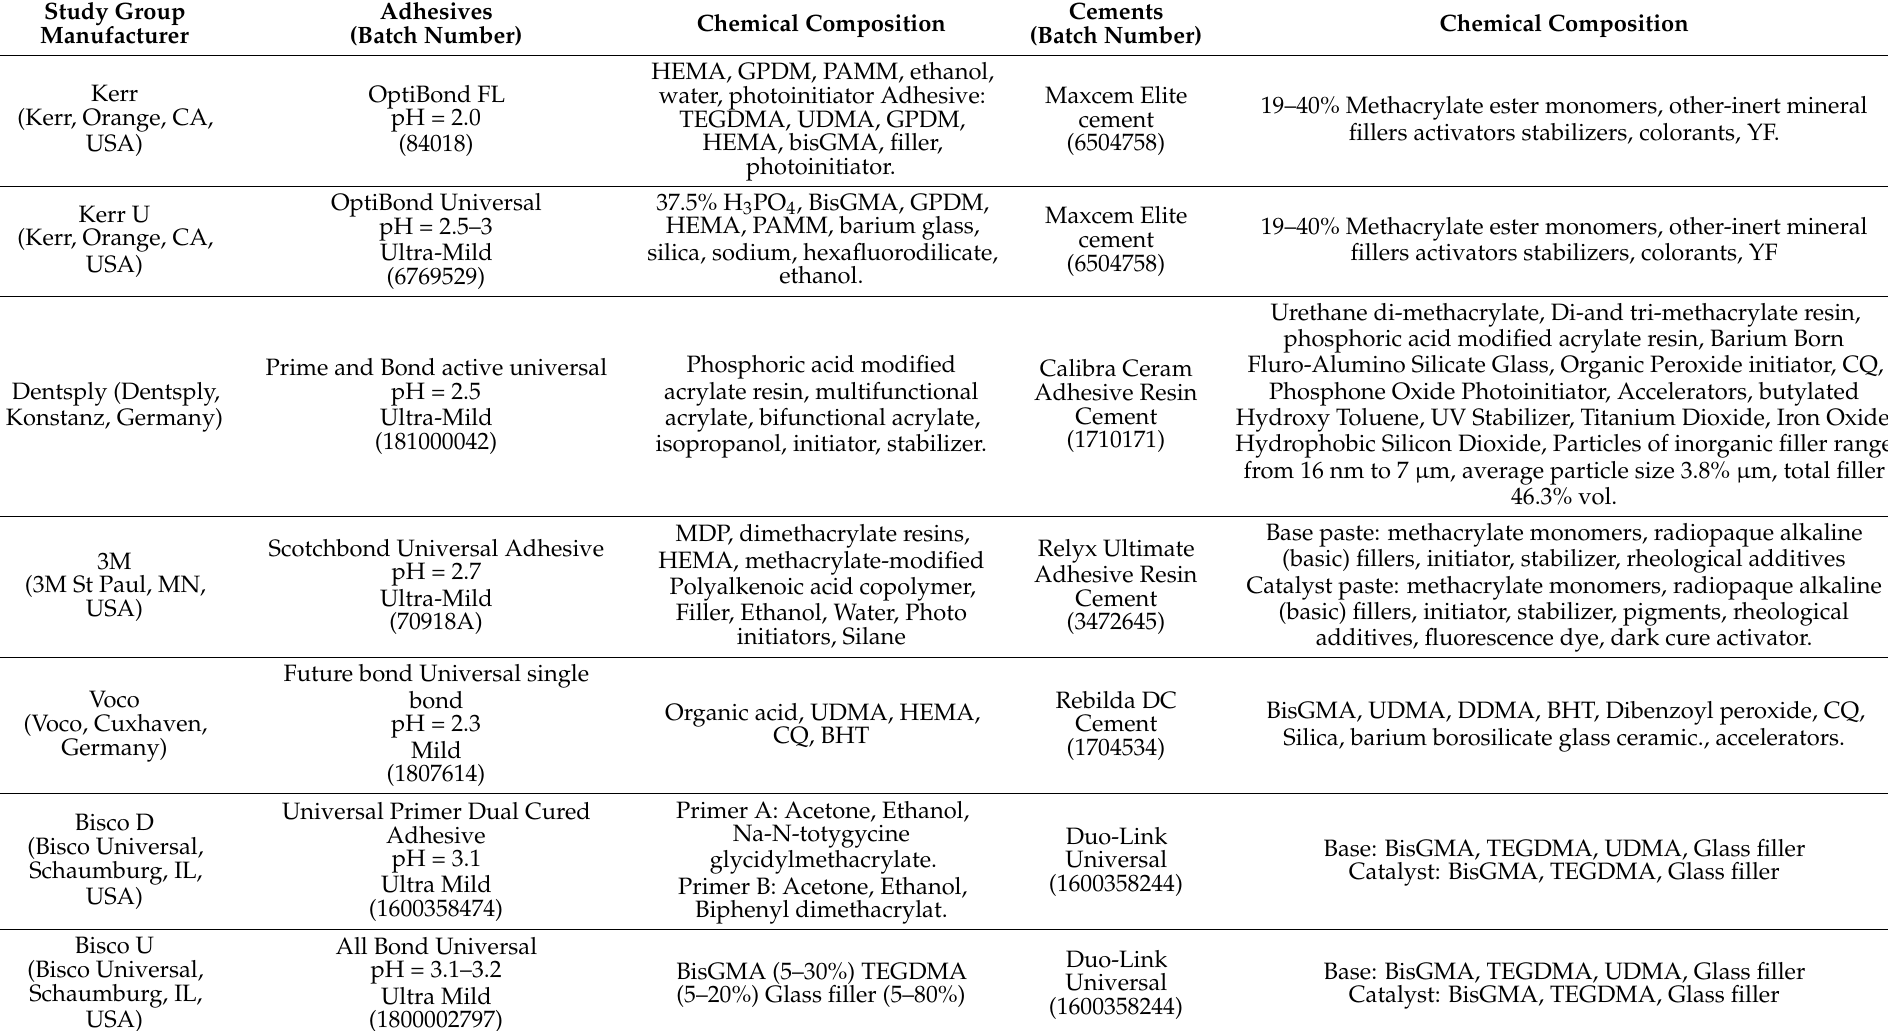
Table 1. Manufacturer and main chemical composition of the different products used in this